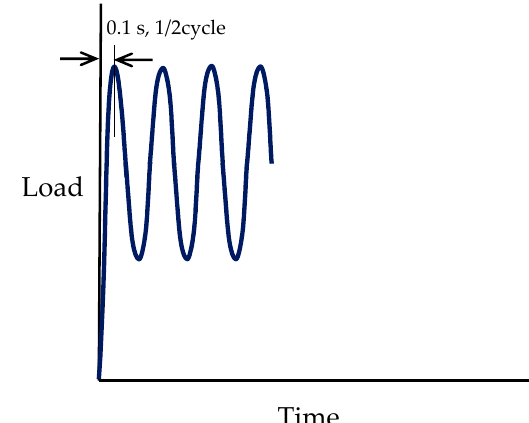
Figure 3. Schematic breaking point of R = 0.4 at 0.5 cycle.